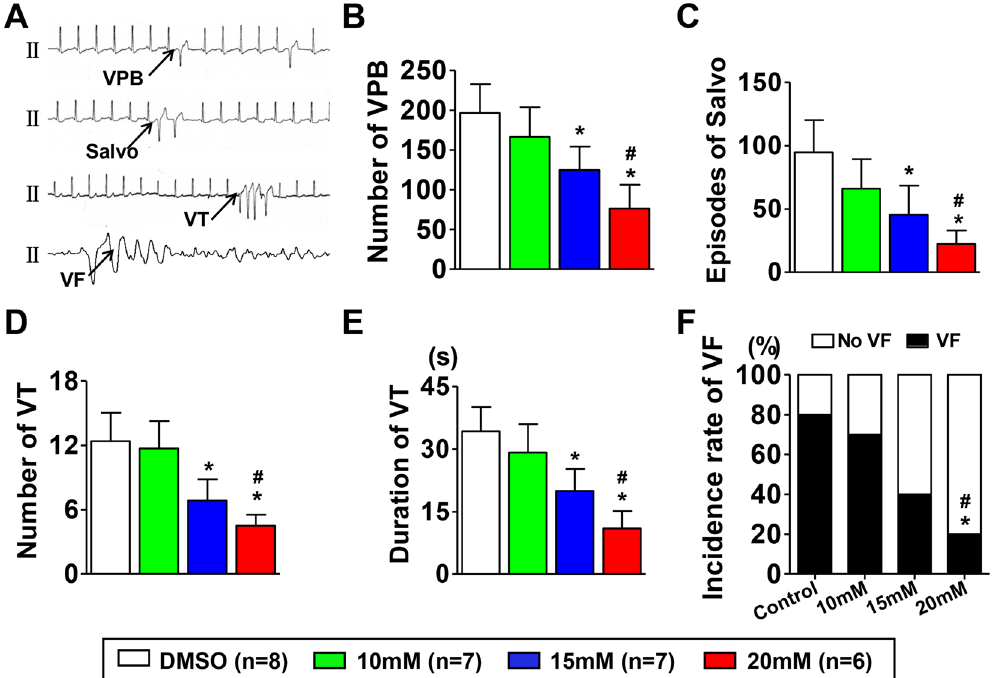
Figure 3. Effects of Nav1.8 channel block on VA episodes. ( A ) Representative ECG examples. ( B–E ) Quantitative analysis of the number and duration of different types of VA. * p < 0.05 vs DMSO group, # p < 0.05 vs 10 mM group. VA = ventricular arrhythmia; VPB = ventricular premature beat; VT = ventricular tachycardia; VF = ventricular